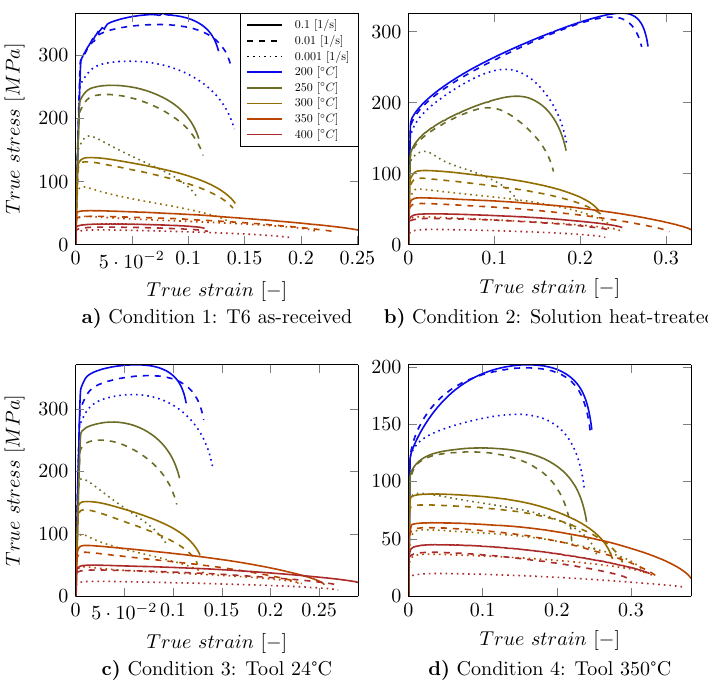
Figure 2. Results of the tensile tests of the conditions: ( a ) T6 as-received, ( b ) Solutions heat-treated, ( c ) Tool 24 ◦ C and ( d ) Tool 350 ◦ C [5]. The color represents the temperature and the line style represents the strain rate